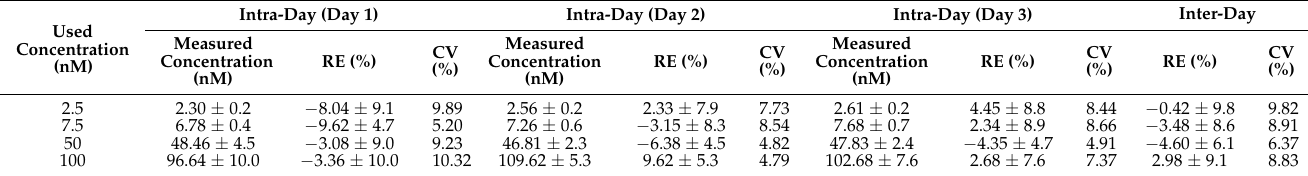
Table 1. Inter-day and intra-day accuracy, expressed as relative error (RE) ± standard deviation (SD), and precision, determined as the coefficient of variation (CV), of five different samples each from three days of PDA-66 at LLOQ (2.5 nM), low (7.5 nM), medium (50 nM) and high (100 nM) concentrations. The measured concentrations are given as mean values ± SD, n = 5 for intra-day, n = 15 for